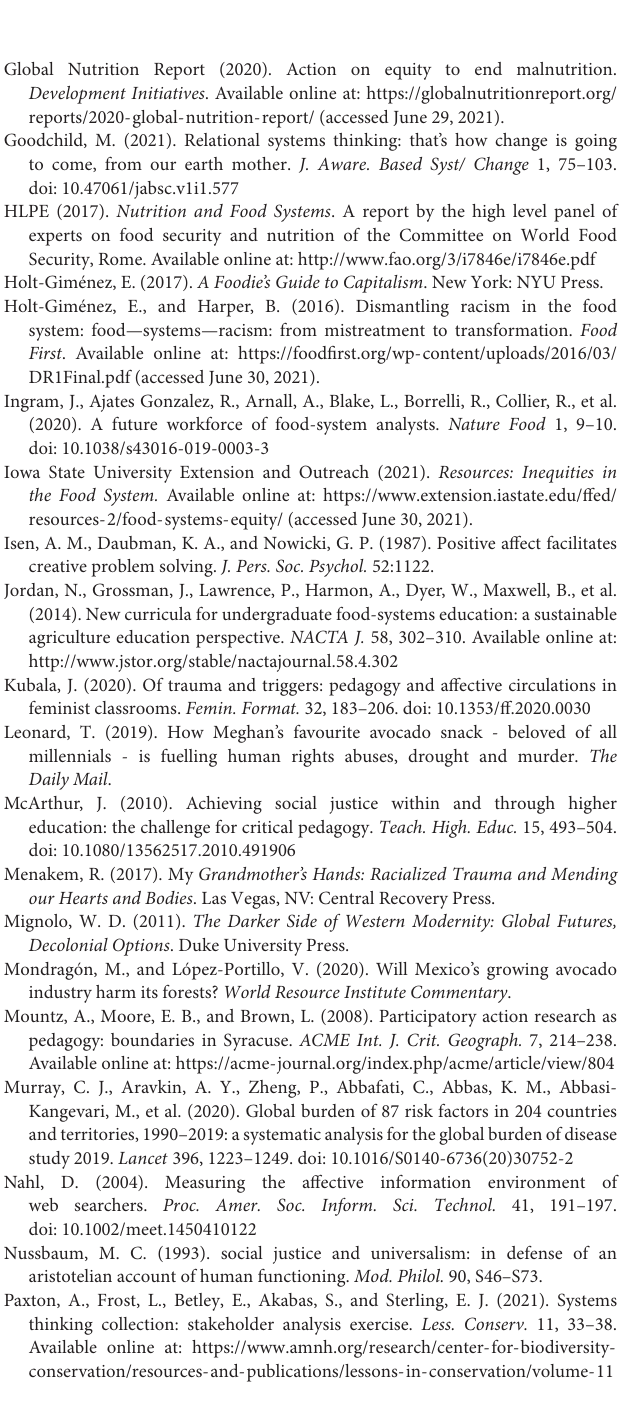
Supplementary Data Sheet 1 | Appendix 1: Selected training and resources for educators to Supplement Table 1 .